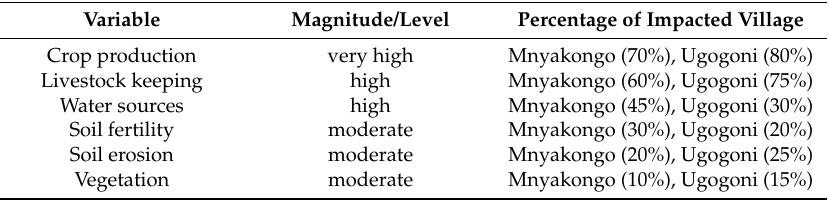
Table 6. Vulnerability Levels in the Sampled Villages (Combined).